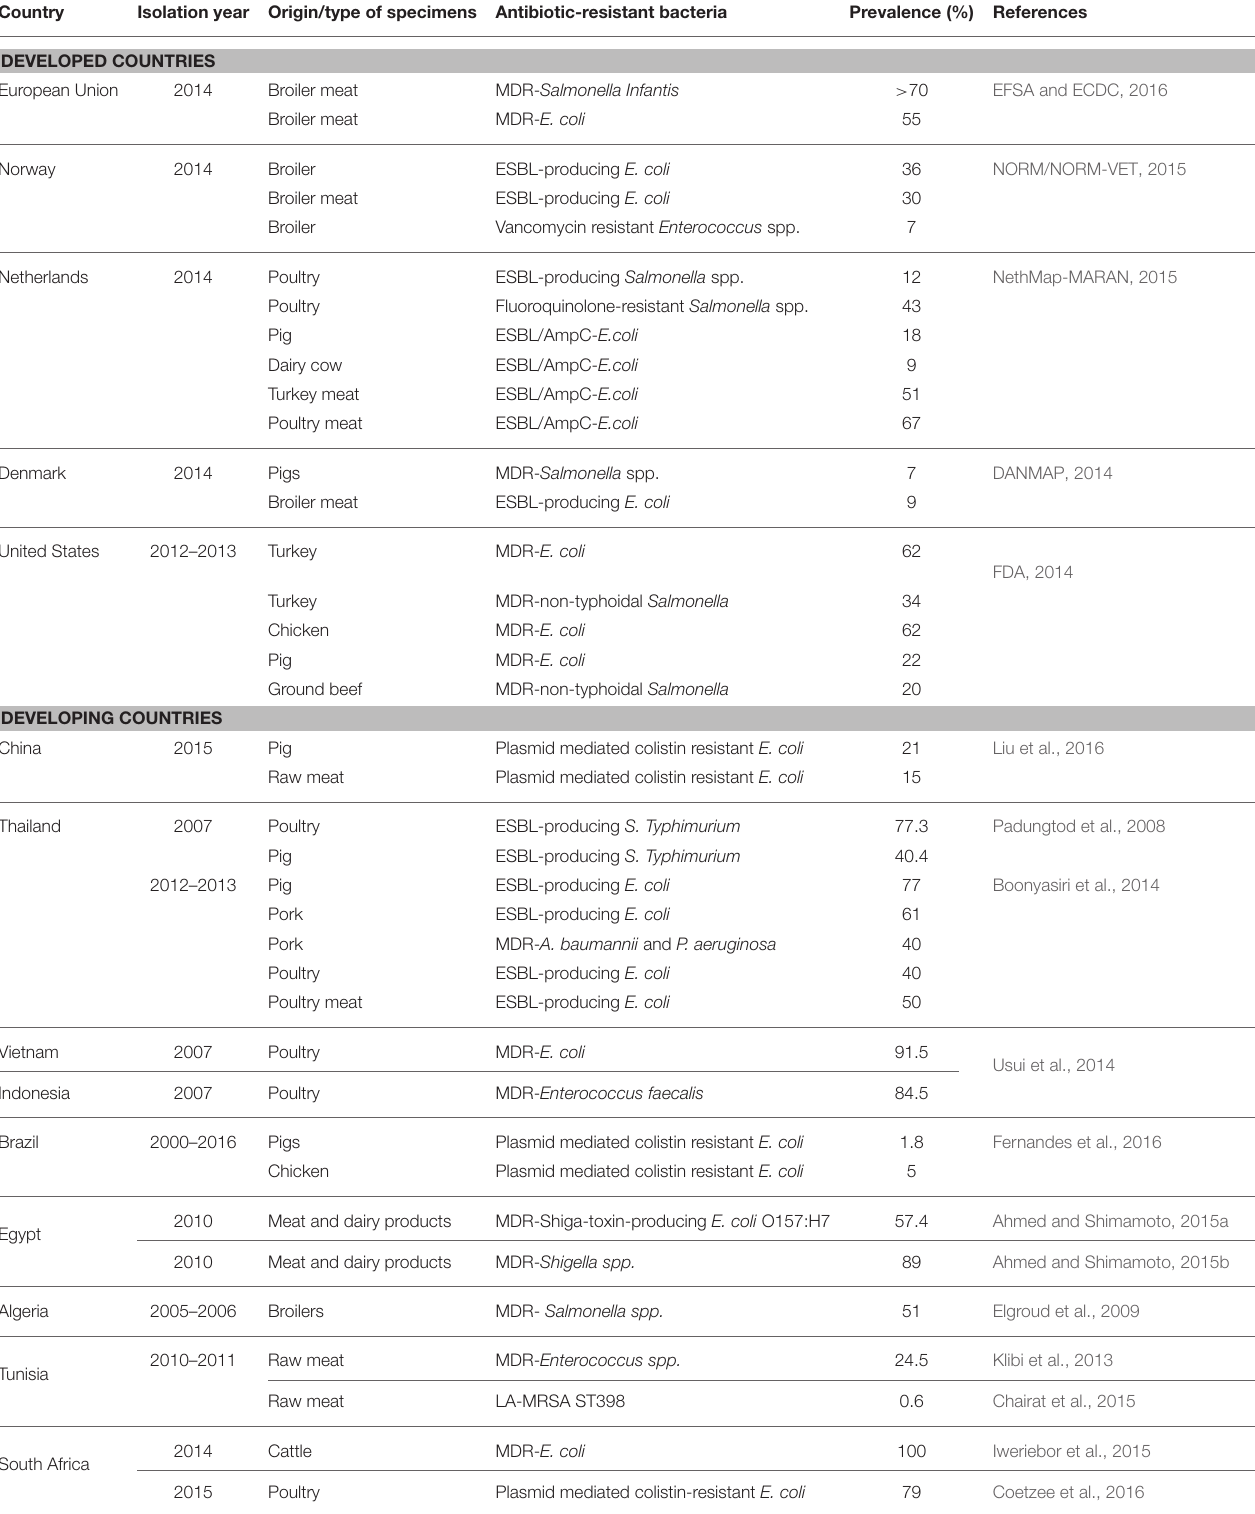
TABLE 2 | Prevalence of antibiotic-resistant bacteria isolated from food animals and products in developed and developing countries.